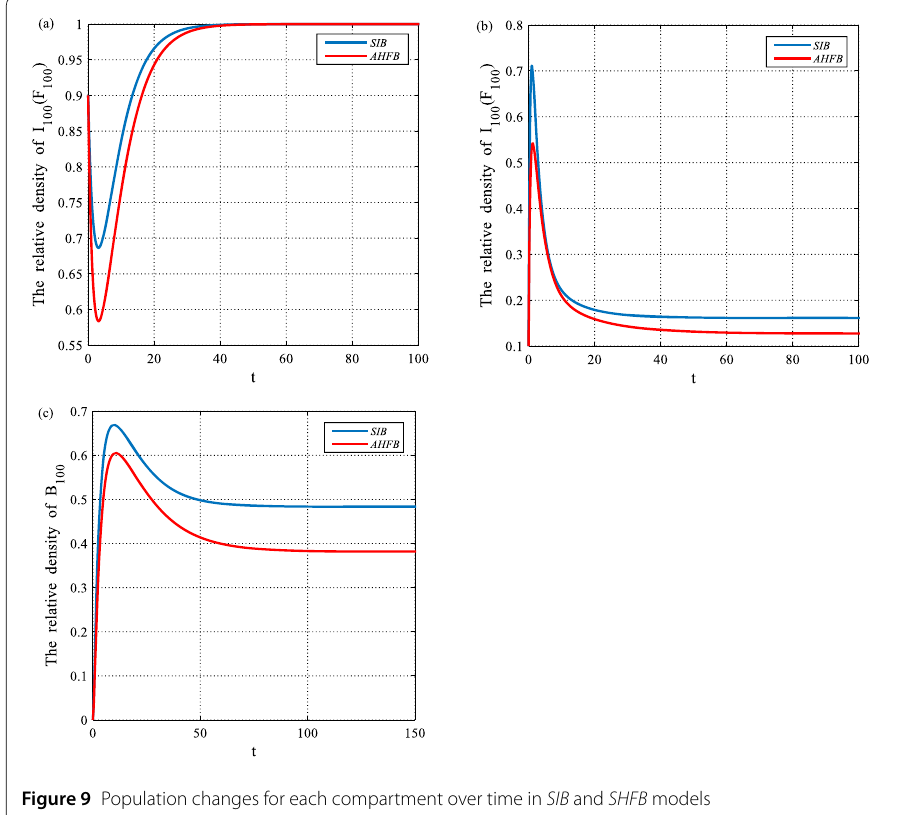
Figure 9 Population changes for each compartment over time in SIB and SHFB models